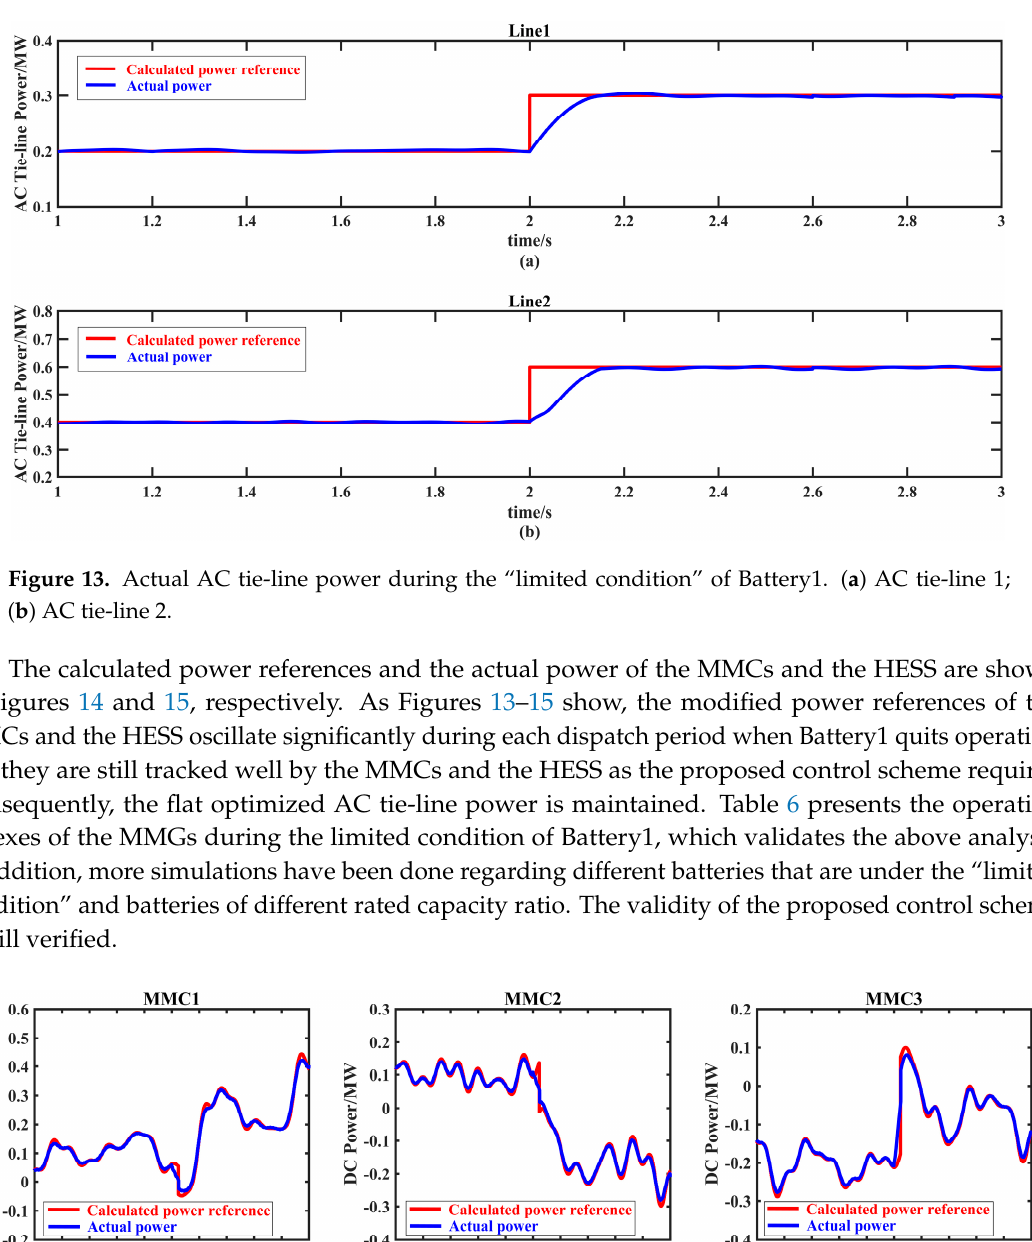
Figure 15. Calculated and actual power of the HESS. ( a ) Battery2; ( b ) Battery3; ( c ) SMES.